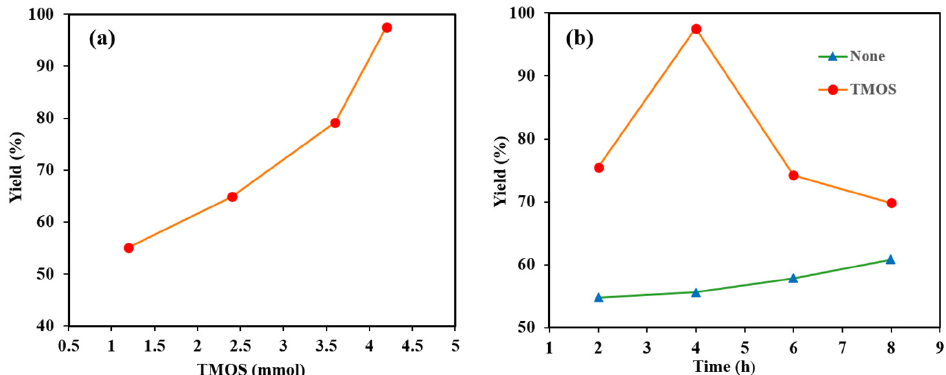
Figure 3. ( a ) Effect of the amount of TMOS on hydroesterification reaction of ethylene with CO 2 . Reaction conditions: Ru 3 (CO) 12 (0.042 mmol), [Bmim]Cl (5.6 mmol), Methanol 5.6 mL, Ethylene 0.2 Mpa, CO 2 4.0 Mpa, 200 °C, 4 h. ( b ) Effect of reaction time on hydroesterification reaction of ethylene with CO 2 . Reaction conditions: Ru 3 (CO) 12 (0.042 mmol), [Bmim]Cl (5.6 mmol), TMOS (4.2 mmol), Methanol 5.6 mL, Ethylene 0.2 Mpa, CO 2 4.0 Mpa, 200 °C.